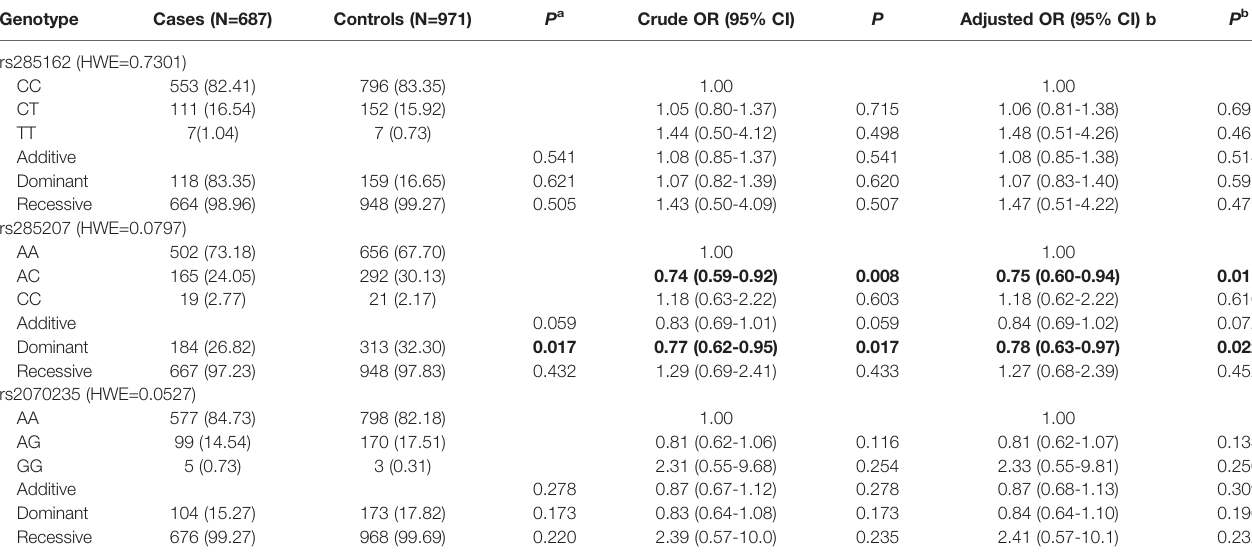
a c 2 test for genotype distributions between ALL cases and cancer-free controls. b Adjusted for age and sex. The bold values were statistically signi fi cant